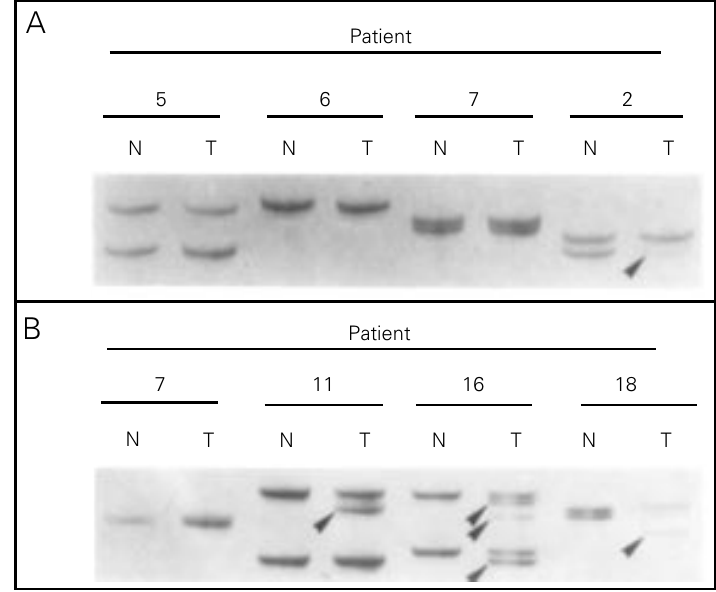
Figure 1 - Examples of the detection with microsatellites of loss of heterozygosity and microsatellite instability in colorectal carcinomas. A , Silver-stained polyacryla- mide gel containing D18S51 alleles amplified from the normal mucosa (N) and tumor (T) of four patients (identified by numbers) with colorectal adenocarcinoma. The tumor from patient 2 presents loss of heterozygosity (arrowhead). Patient 6 is homozygous and consequently is not informative. B , Silver-stained polyacrylamide gel containing D12S67 alleles amplified from the normal mucosa (N) and tumor (T) of four patients (identified by numbers) with colorectal adenocarcinoma. The tumors from patients 11, 16 and 18 present microsatellite instability identified by the appearance of new mutant alleles